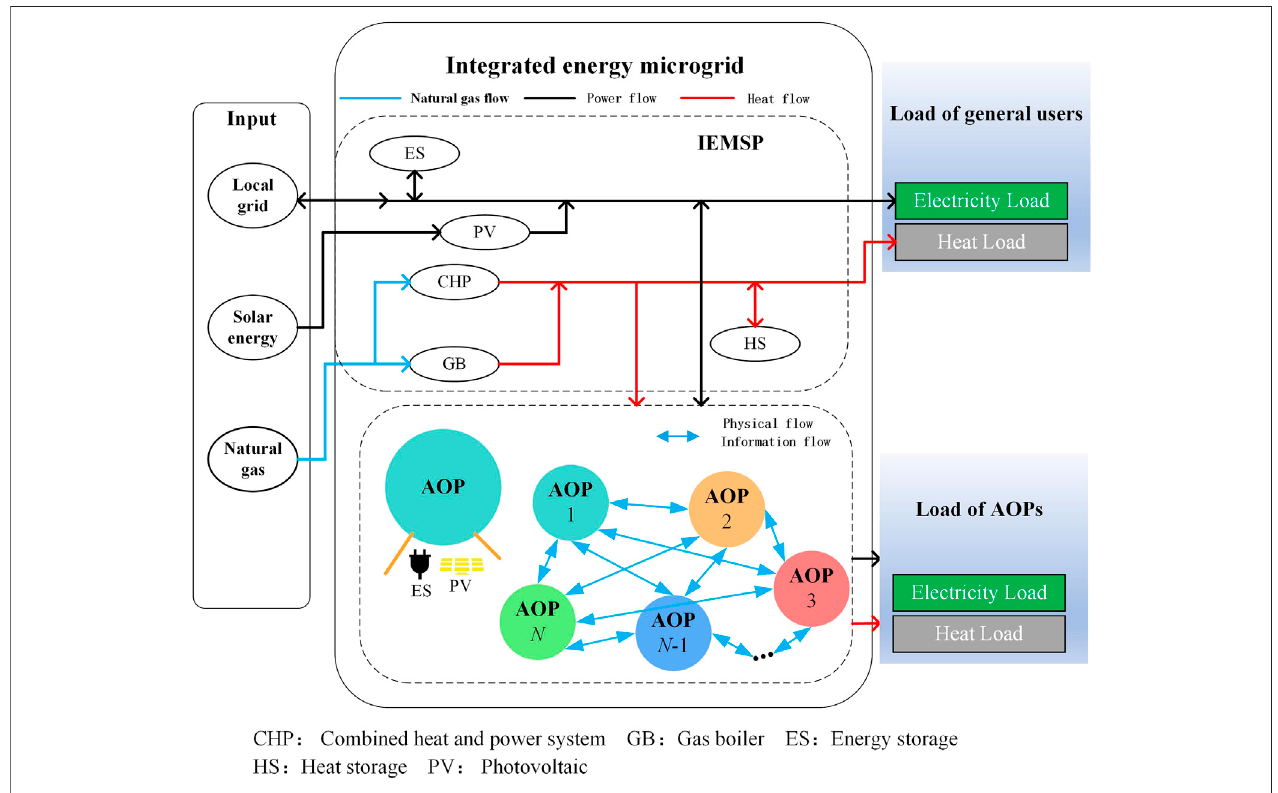
FIGURE 2 | IEM architecture considering